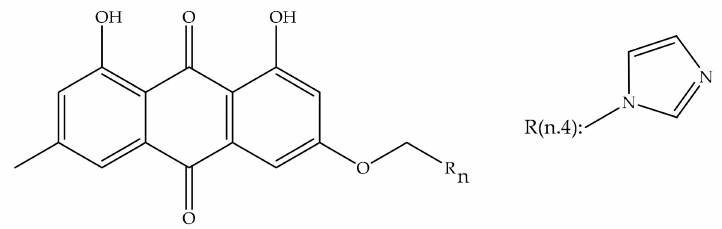
Figure 13. Chemical structure of some potent synthesized